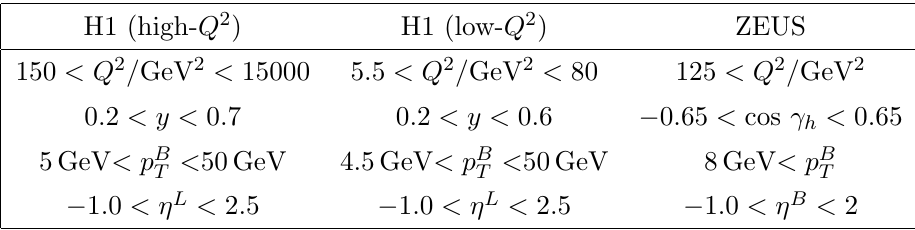
Figure 4 . Contributions to inclusive jet production ( k T -algorithm with R 0 = 1) from (cid:12)rst, second, third and fourth